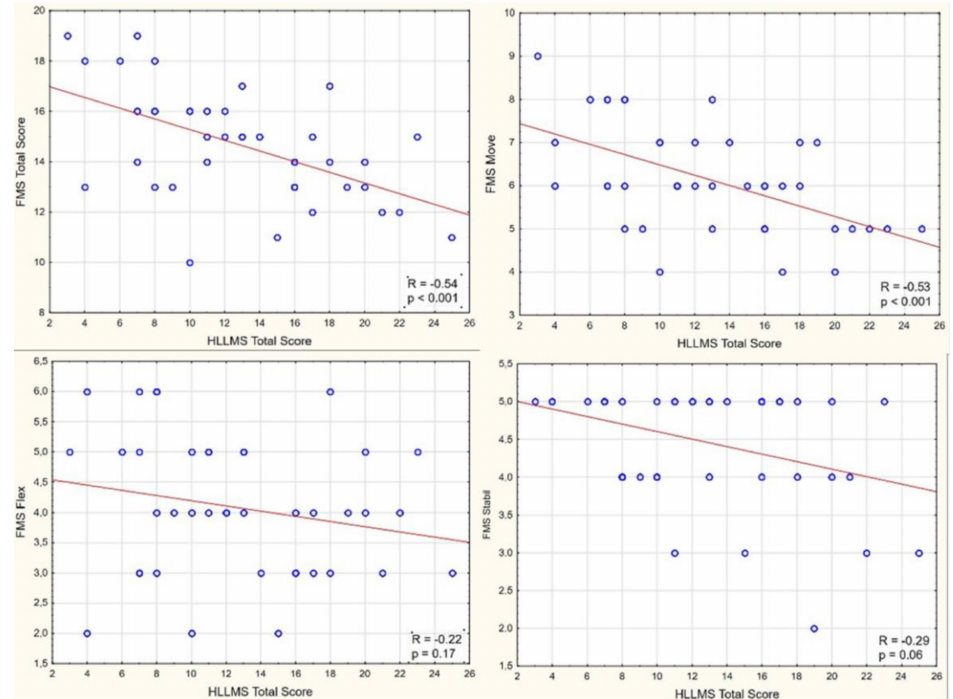
Figure 1. Total score of the Hip and Lower Limb Movement Score (HLLMS) in relation to total score of the Functional Movement Screen (FMS) and sub-scores of stability, flexibility, and movement (data on 41 footballers—some participants obtained the same pair of HLLMS and FMS scores; therefore, their points are superimposed).